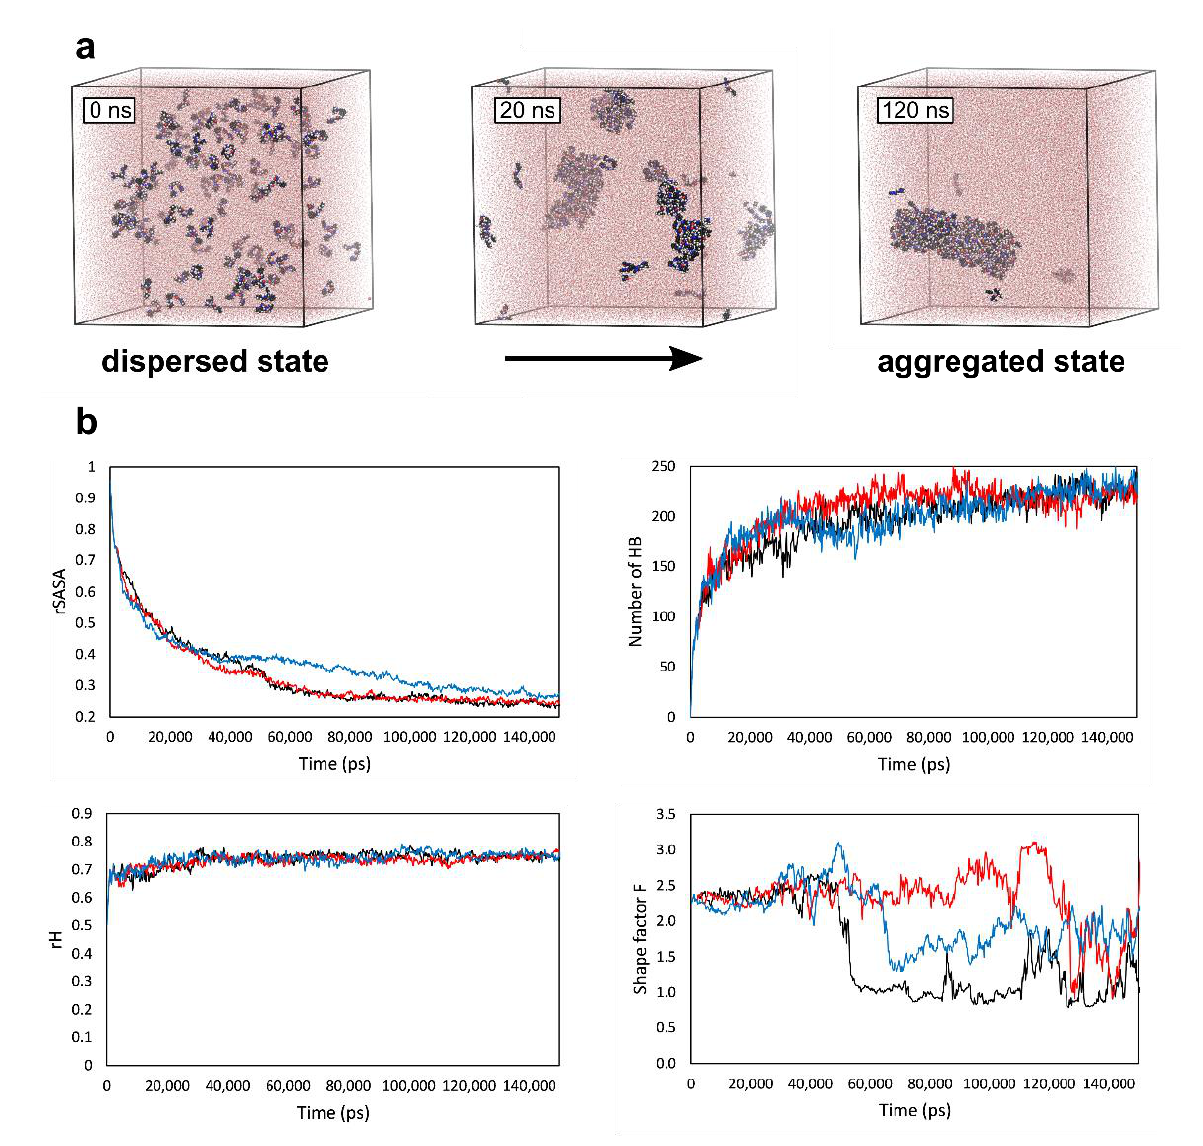
Figure 2. Molecular dynamics simulations were used to probe the early aggregation phase of p2 o 1 in water. ( a ) Snapshots taken from an MD trajectory of 100 p2 o 1 gelator molecules dispersed in water (TIP3P-model) at a concentration of 1.0% w / v at 0 ns, 20 ns, and 120 ns, respectively. Gelator molecules were visualized through Van der Waals surfaces, while water molecules were visualized as a stick model for clarity purposes. ( b ) Evolution of the descriptors rSASA, the number of hydrogen bonds, rH, and shape factor F during three independent (red, blue, black) MD simulations of 150 ns. A VT- 1 H-NMR experiment of the p2 o 1 gel at a concentration of 1.0% w / v in H 2 O:D 2